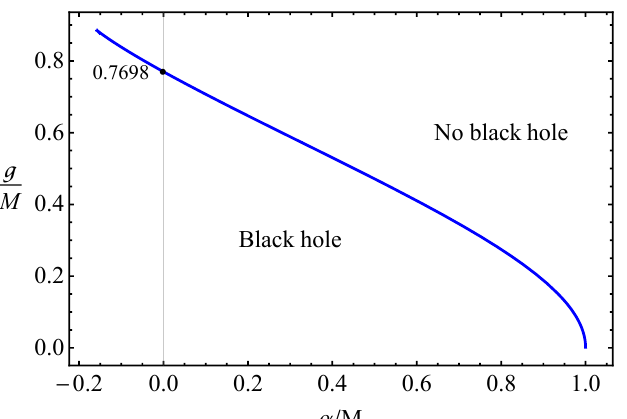
Figure 3. Relations between the values of parameter α and the BH charge g for the existence of the Bardeen BH